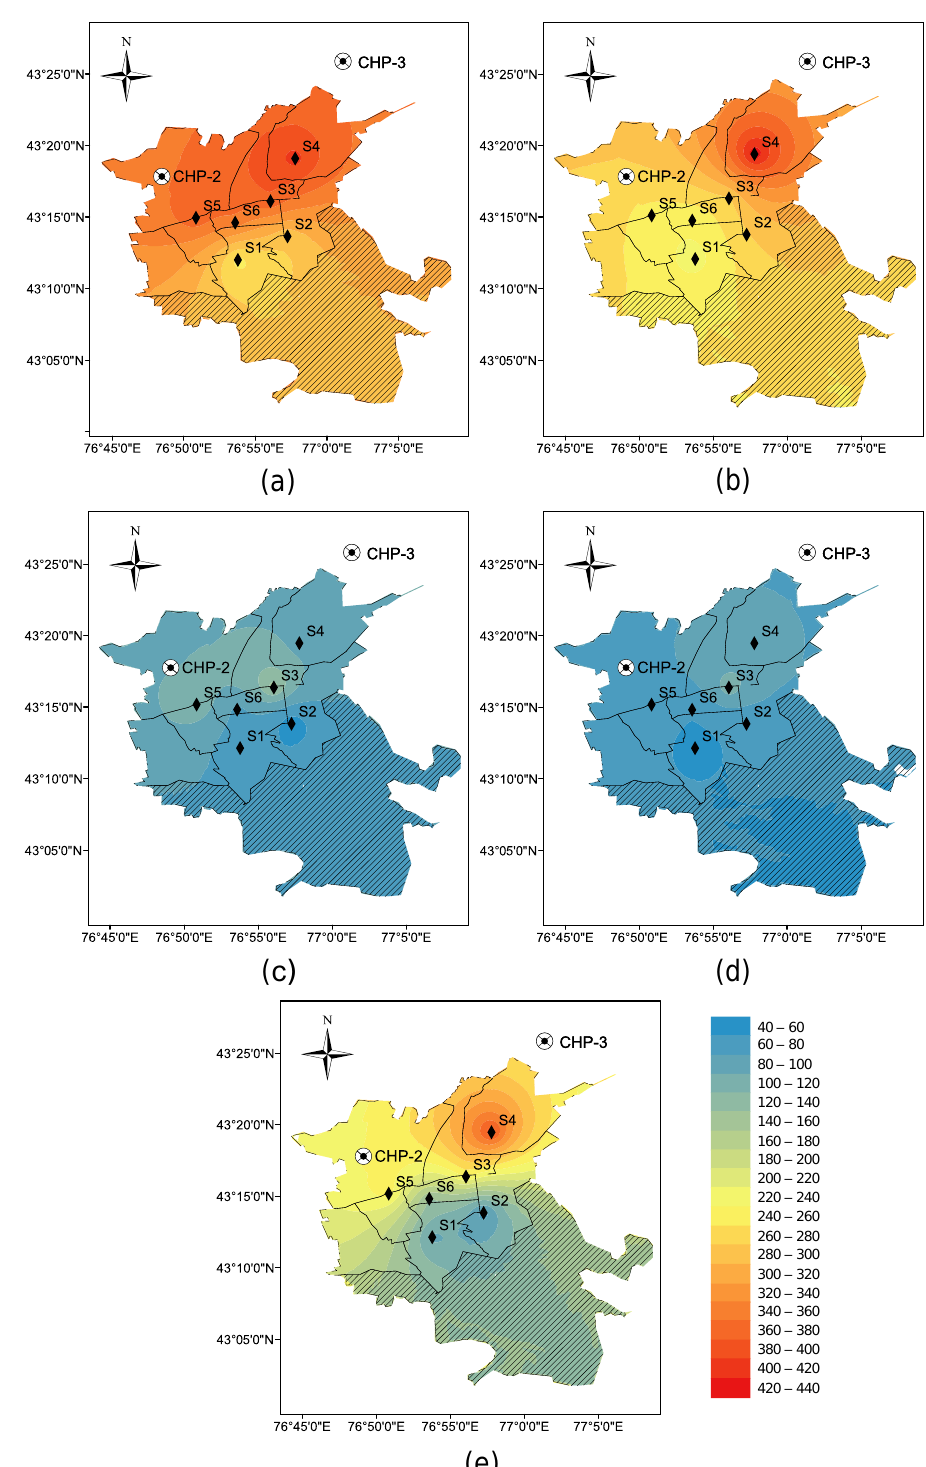
Figure 4. Spatial distribution of total VOCs concentrations during sampling periods in 15, 17, 19 January ( a ), 3, 5, 7 April ( b ), 28, 30 April, 3 May ( c ), 22, 24, 26 July ( d ), and 21, 23, 25 October ( e ).